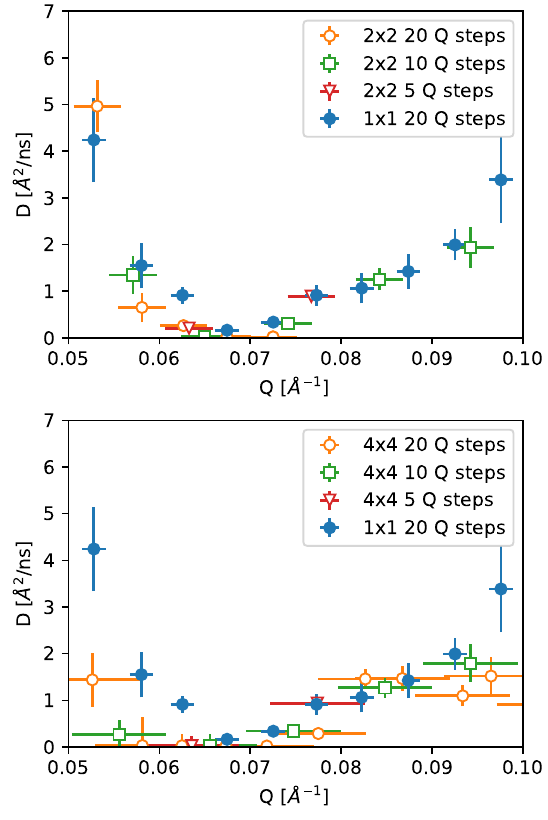
Figure 7. Variation of pixel binning and Q-binning: the most significant di ff erence is the lower di ff usion constant if evaluated with a coarser binning, most likely due to contributions from the Bragg peak contributing to more Q-bins. The 2x2 pixel grouping evaluation seems to be a good compromise between statistics and resolution. The dQ errorbars represent the error in Q due to the pixel grouping